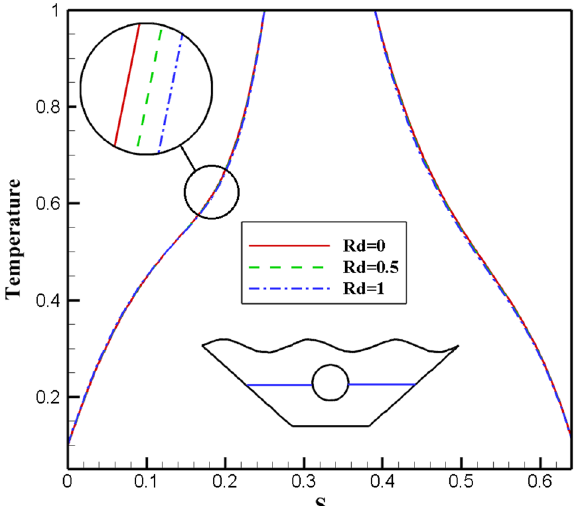
Figure 19. Temperature plot for different Radiation (Rd).